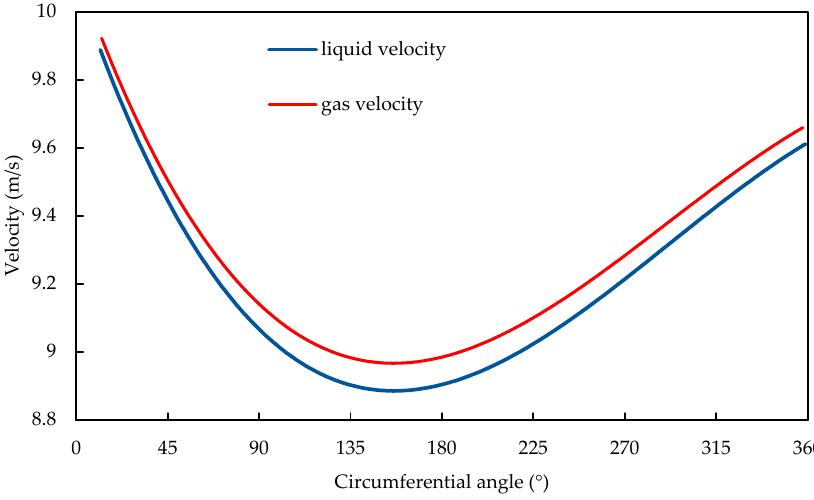
Figure 6. Gas and liquid axial velocity with the circumferential position.